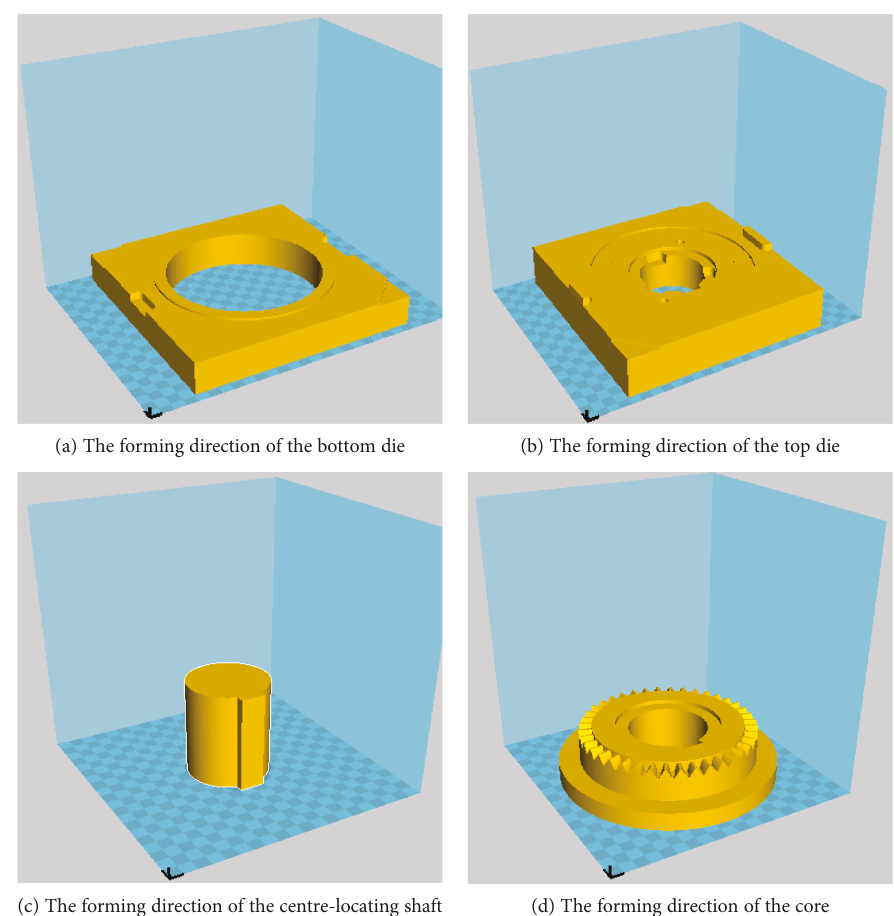
Figure 8: Selection of the forming direction for the spur face gear master mould.